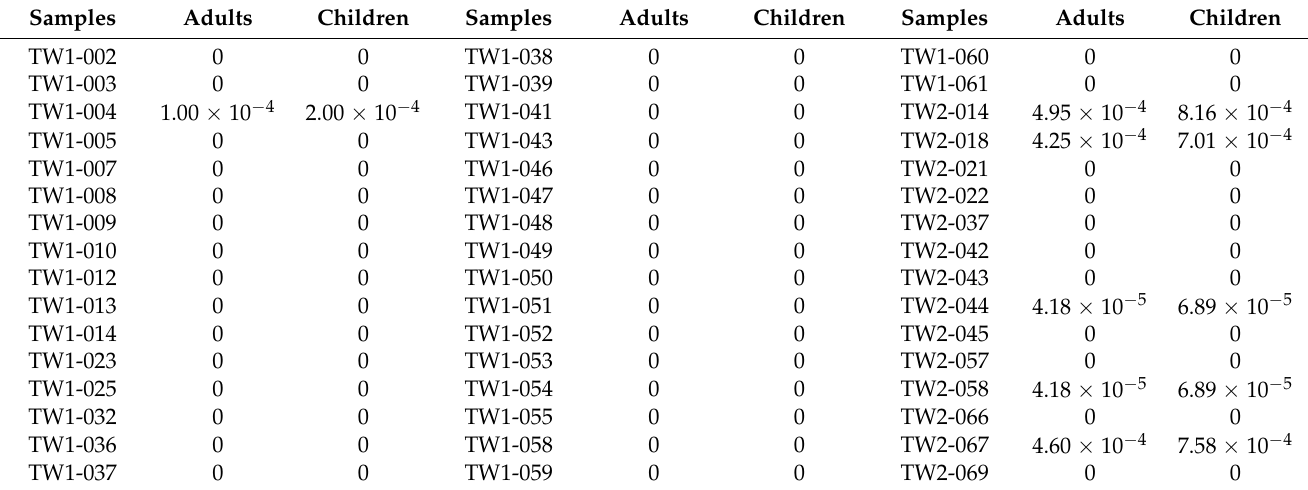
Table 7. Calculated carcinogenic risk due to Cr 6+ in water intake and dermal contact.